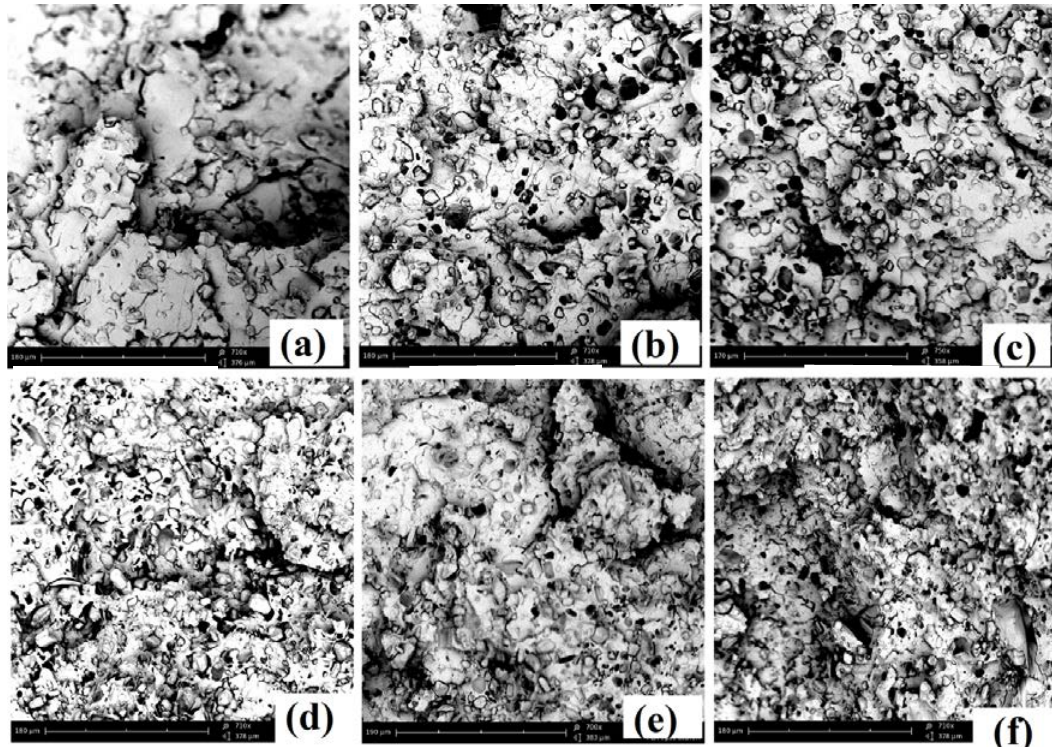
Figure 9. SEM analysis of PLA/APP10 ( a ), PLA/APP15 ( b ), PLA/APP20 ( c ), PLA/APP20/ST3 ( d ), PLA/APP20/ST5 ( e ), and PLA/APP20/ST7 ( f ) composites. Scale bar in all panels = 180 µ m, Magnification = 710 ×